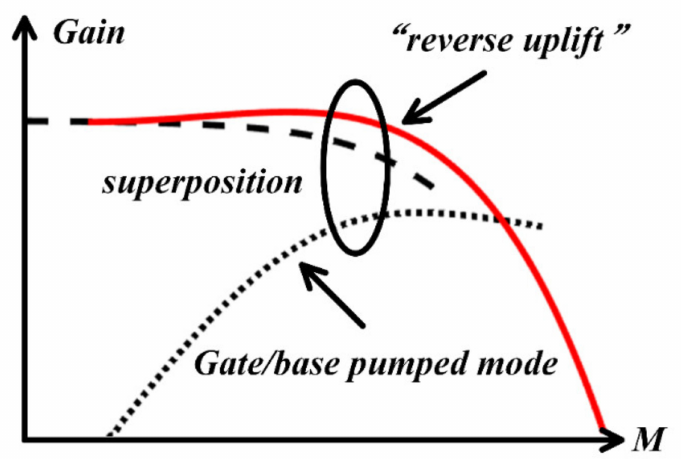
Figure 4. Superposition of the two